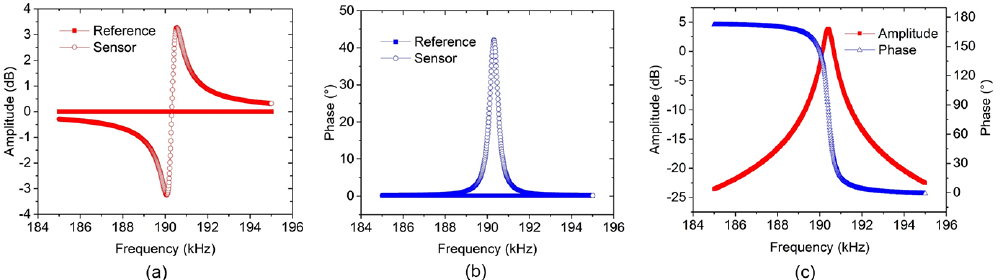
Figure 7. Differential simulation of (a) an asymmetric amplitude shape and (b) a reversed phase response with a reference signal, (c) resulting in a compensated symmetric amplitude shape (red, full squares) and a monotonic phase (blue, open triangles) response about f 0